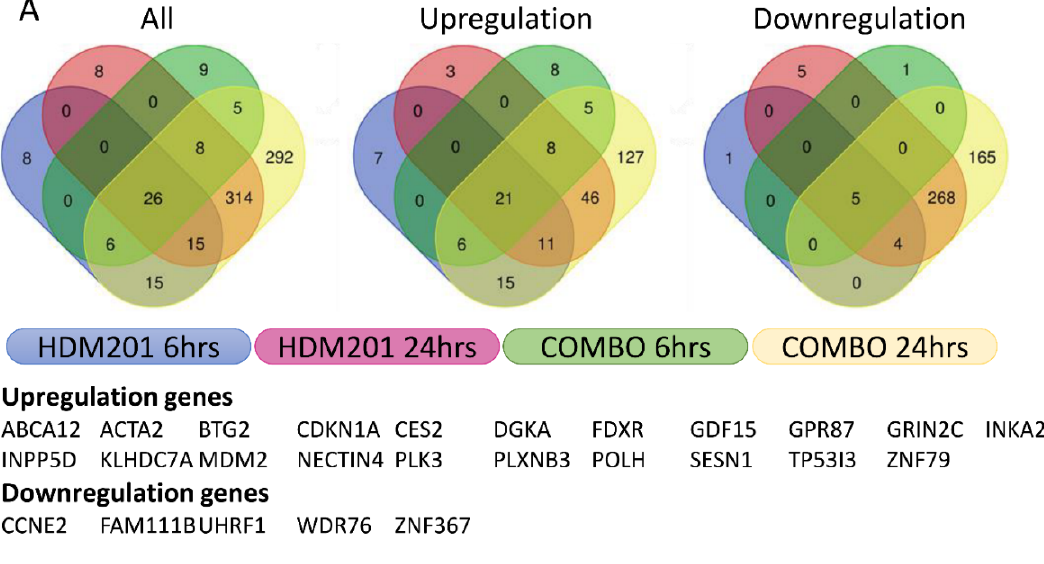
Figure 6. Comparative transcriptomic analyses between treatment with HDM201 alone and in combination with WIP1i (COMBO) for 6 and 24 h in RBE cells. ( A ) Venn diagram of all (left), upregulated (middle), and downregulated (right) differentially expressed genes, as selected according to a >2-fold change and p < 0.05. ( B ) REB was treated with HDM201 and GSK2830371 for 24 h. Seventy-seven differentially expressed genes with fold change ≥ 2 were analyzed by gene ontol- ogy (GO) enrichment analysis with Database of Immune Cell Expression (DICE) database using GO-net.